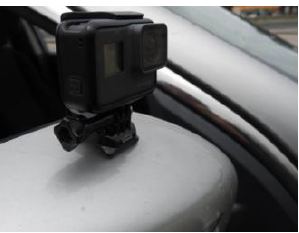
Figure 1. GoPro camera in its mounting box, fixed on the side rear view mirror of a vehicle.